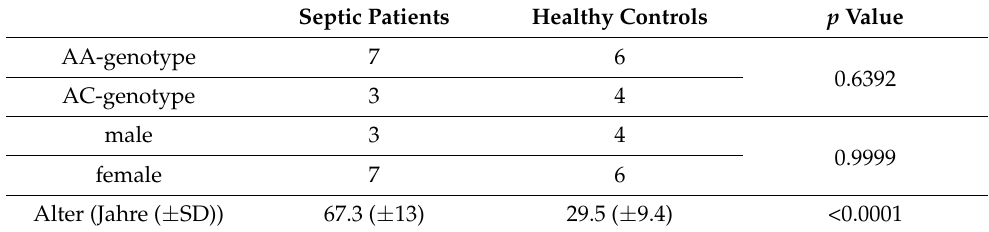
Table 2. Comparison between septic patients and healthy controls.